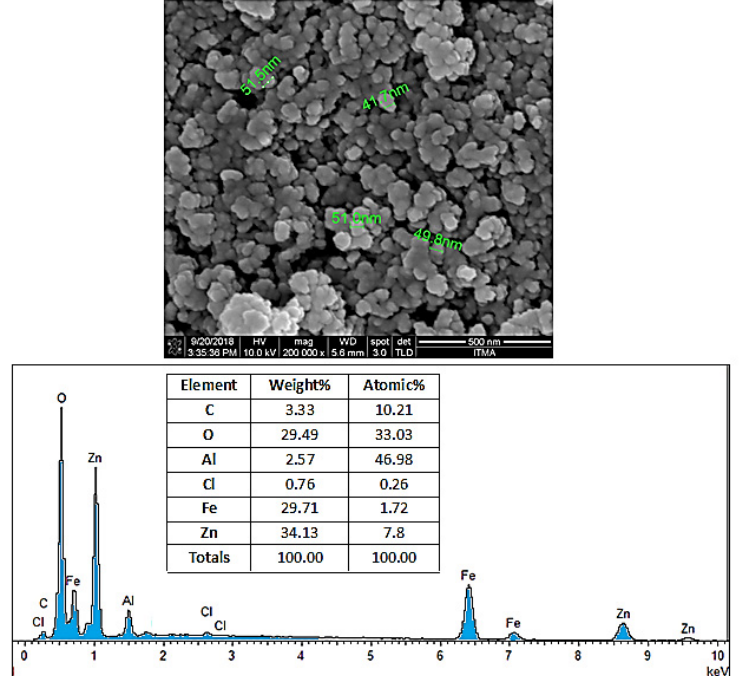
Figure 6. Field emission scanning electron microscope (FESEM) images of drug-loaded magnetic nanoparticles (M-PEG–SO–ZLDH) and their FESEM-EDX spectra. The specimen holder is made of